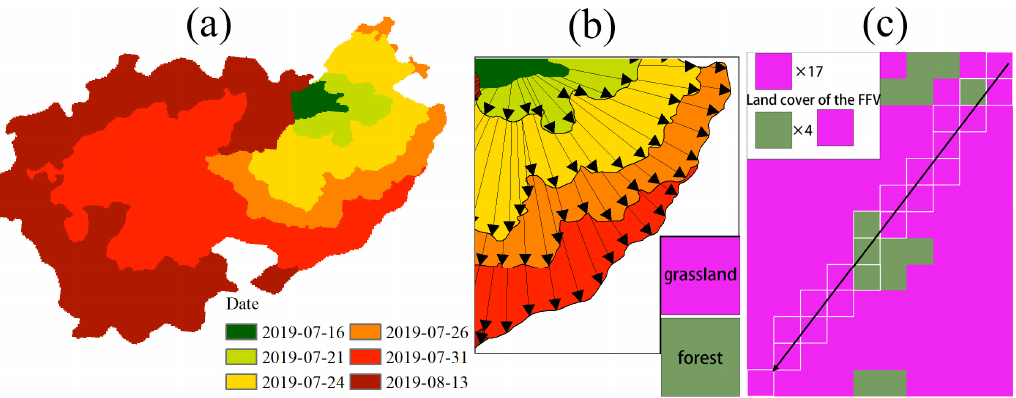
Figure 5. Fire front vectors. ( a ) An example of the progression of a single fire and ( b ) the associated fire front vectors for a portion of the fire. ( c ) Determination of land-cover type of an FFV. In this example, the FFV is assigned to grassland.